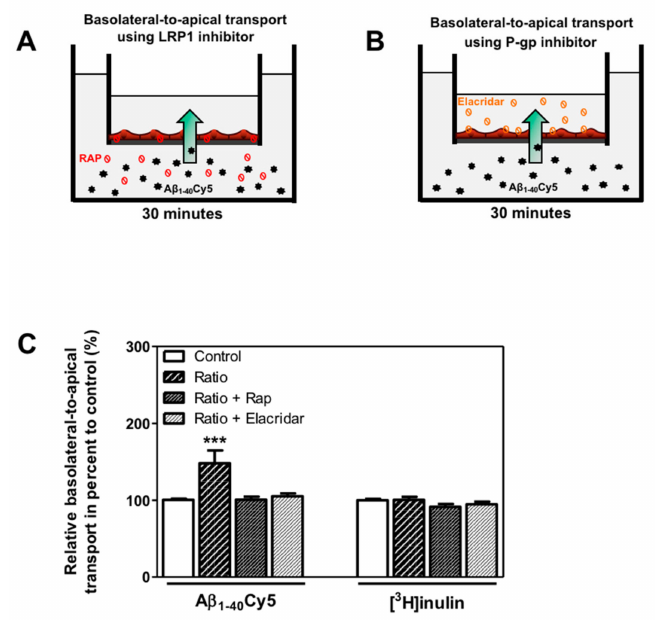
Figure 5. Involvement of LRP1 and P-gp in basolateral-to-apical transport of A β 1–40 Cy5 peptide after ratio KB treatment. ( A ) Schematic representation of the human in vitro BBB model used for basolateral to-apical A β transport (green arrow) in the presence of ( A ) LRP1 or ( B ) P-gp inhibitors, respectively RAP (red ban symbol) or elacridar (orange ban symbol). ( C ) A β 1–40 Cy5 or [ 3 H]inulin basolateral-to-apical transport was performed with RAP or elacridar. The data represent the mean ± SEM obtained from at least three independent experiments relative to the control conditions, each of which was performed in triplicate (*** p <